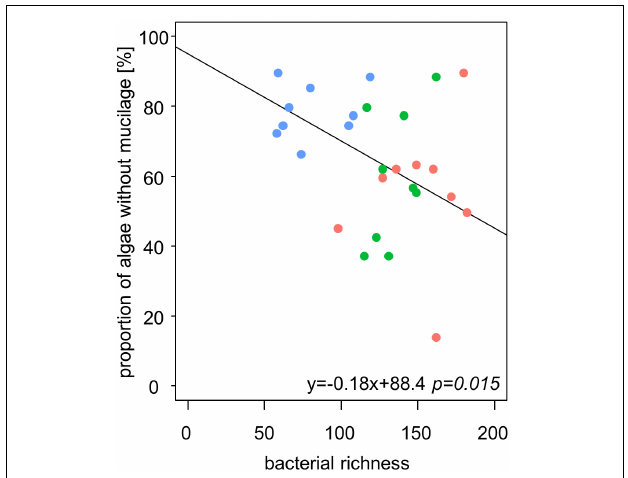
FIGURE 6 | The bacterial richness correlates negatively with the relative content of alga species without mucilage in biocrusts from temperate forests ( n = 27). Line represents the result of a linear